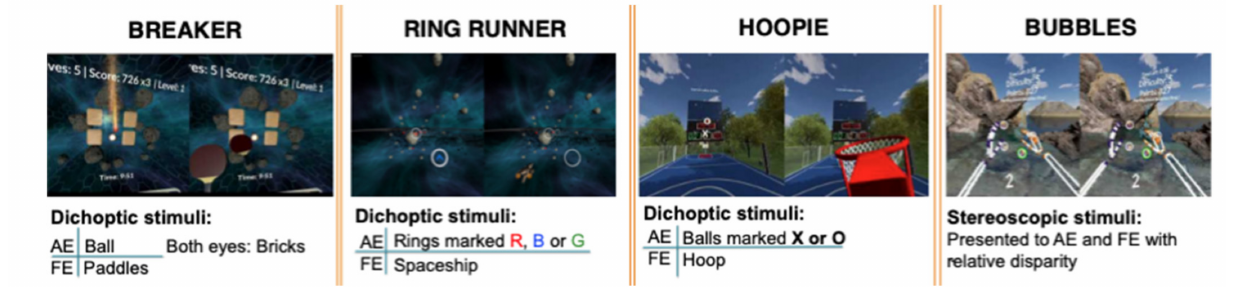
Figure 4. Illustration of four games provided by Vivid